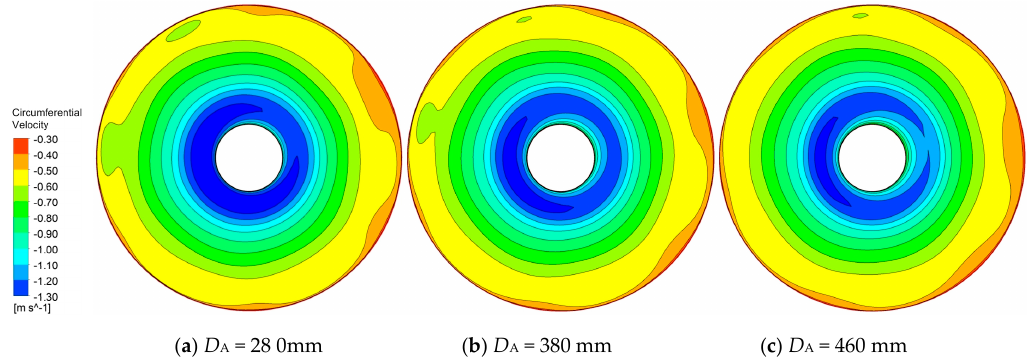
Figure 10. Circumferential velocity distribution at the impeller inlet with different axial distances ( γ = 0 ◦ ).